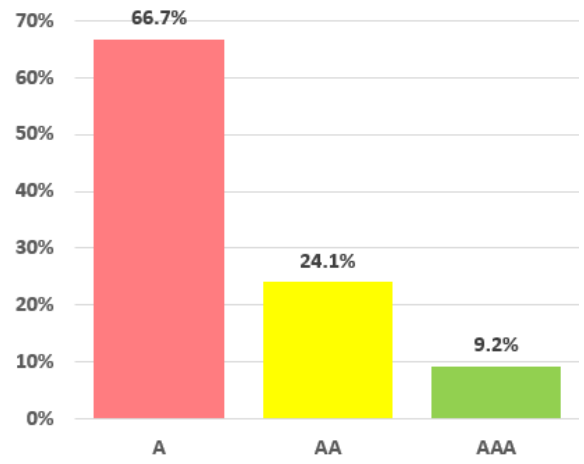
Figure 7. WCAG levels in manual evaluation that exceed the barriers.